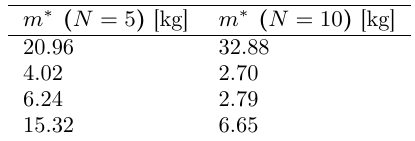
Fig. 6. Evolution of the best found design with the number of iterations using COBYLA for N = 10 . The objective function (a), the frequency constraints (b) (Eq. (3)), and the mass constraint (c) (Eq. (6)) are plotted as a function of the iterations. Table 3. Comparison of optimized stringer sections. Table 4. Comparison of optimized point mass